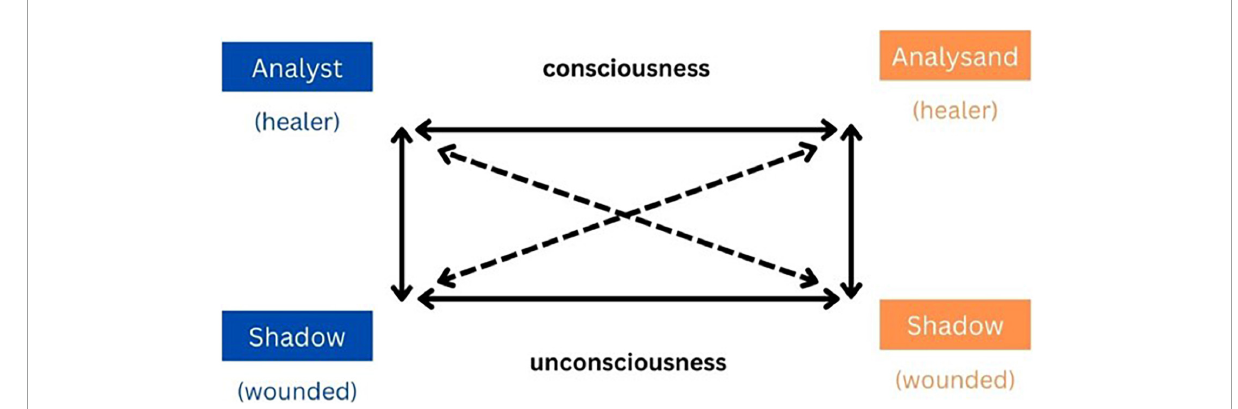
FIGURE1 The relationship between the healer and the wounded (based on Frith Luton, 2019).